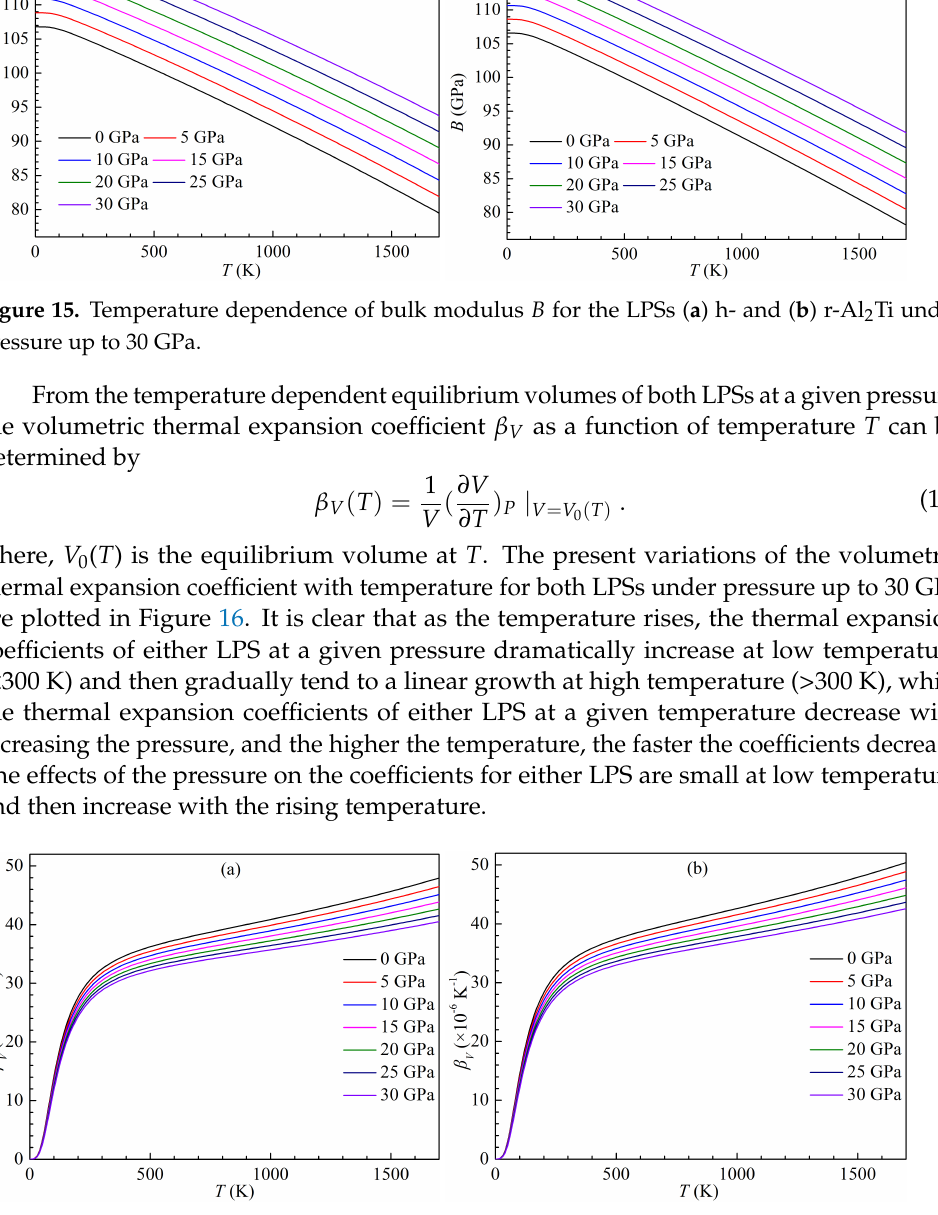
Figure 16. Temperature dependence of thermal expansion coefficient β V for the LPSs ( a ) h- and ( b ) r-Al 2 Ti under pressure up to 30